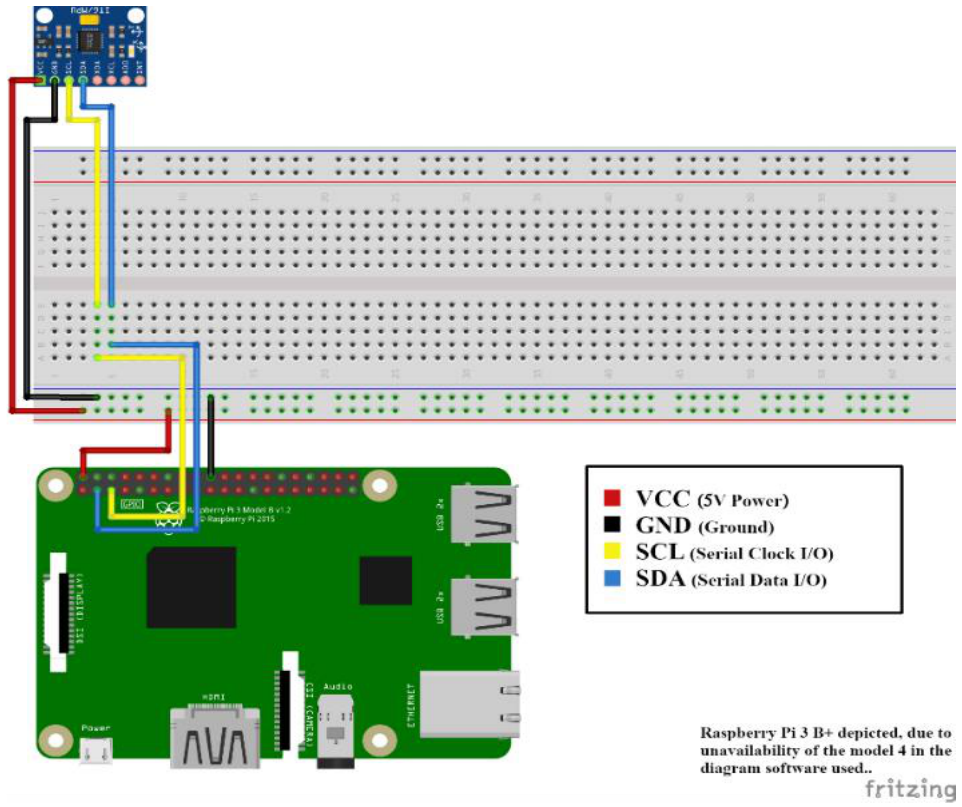
Figure 11. Raspberry Pi 4 Model B/4 GB (SoC) connected to the MPU-6050 accelerometer and gyro- scope.